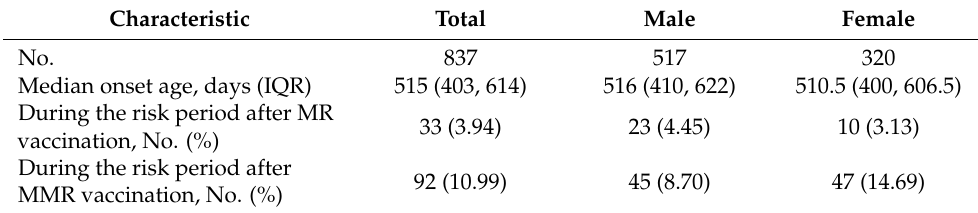
Table 1. Characteristics of the children with FSs included in this